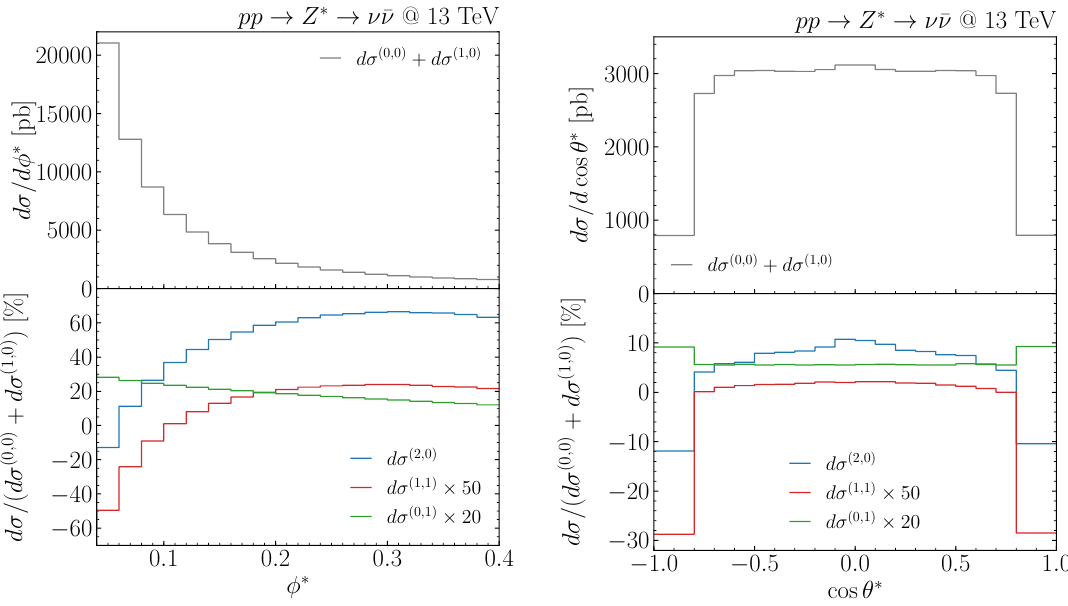
Figure 4 . The (cid:30) (cid:3) distribution. The upper panel shows the NLO QCD prediction, while the lower panel shows the NNLO QCD (blue), NLO QED (green) and mixed (red) corrections, normalized to the NLO